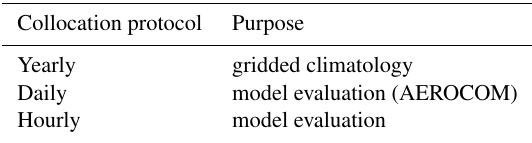
Table 4. Collocation